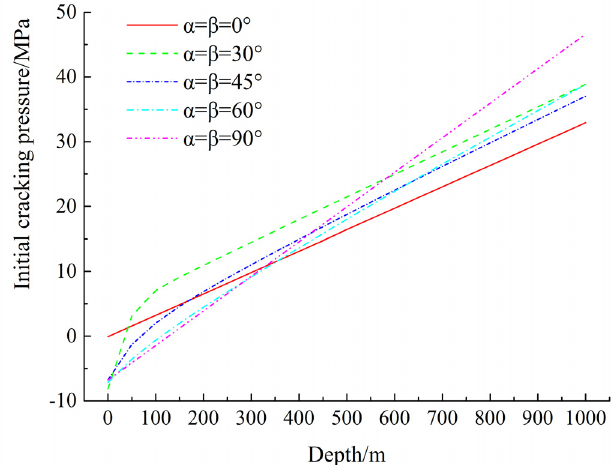
Figure 9. Relationship between the initial cracking pressure and burial